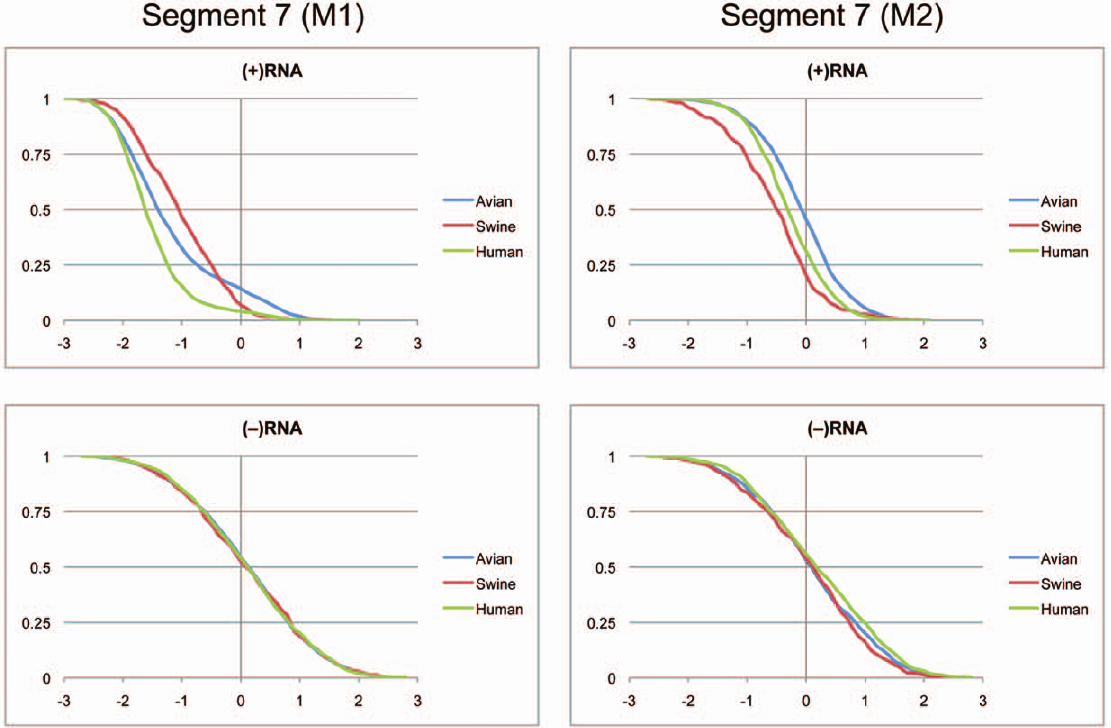
Figure 6. Cumulative distribution plots of z-scores for segment 7 coding regions. M1 and M2 are shown in the left and right panels, respectively. ( + )RNA and ( 2 )RNA are shown in the top and bottom panels, respectively. See Figure 1 for annotations and details.